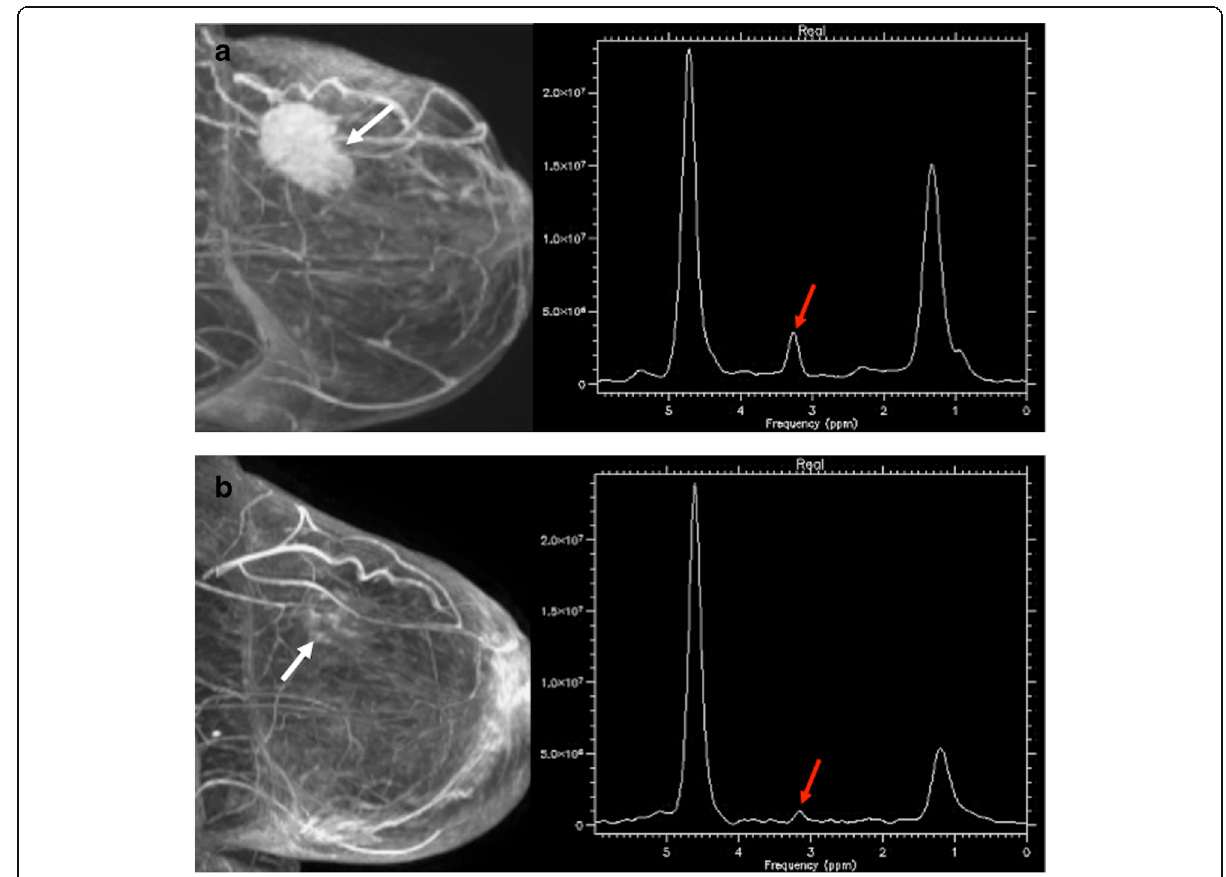
Fig. 16 A 56-year-old woman with an invasive ductal carcinoma of the breast. Pretherapy ( a ) the sagittal reformatted maximum intensity projection (MIP) image from DCE-MRI (left) demonstrating a 5-cm enhancing mass (white arrow). MR spectrum (right) depicts a marked choline peak (red arrow). Images obtained after chemotherapy and anti-HER2 therapy with trastuzumab ( b ) evidenced a residual lesion. Sagittal reformatted maximum intensity projection (MIP) image from DCE-MRI demonstrated discrete dots of enhancement (white arrow), while MR spectrum showed a decreased choline peak (red arrow). Tumorectomy revealed residual fibrosis without tumor